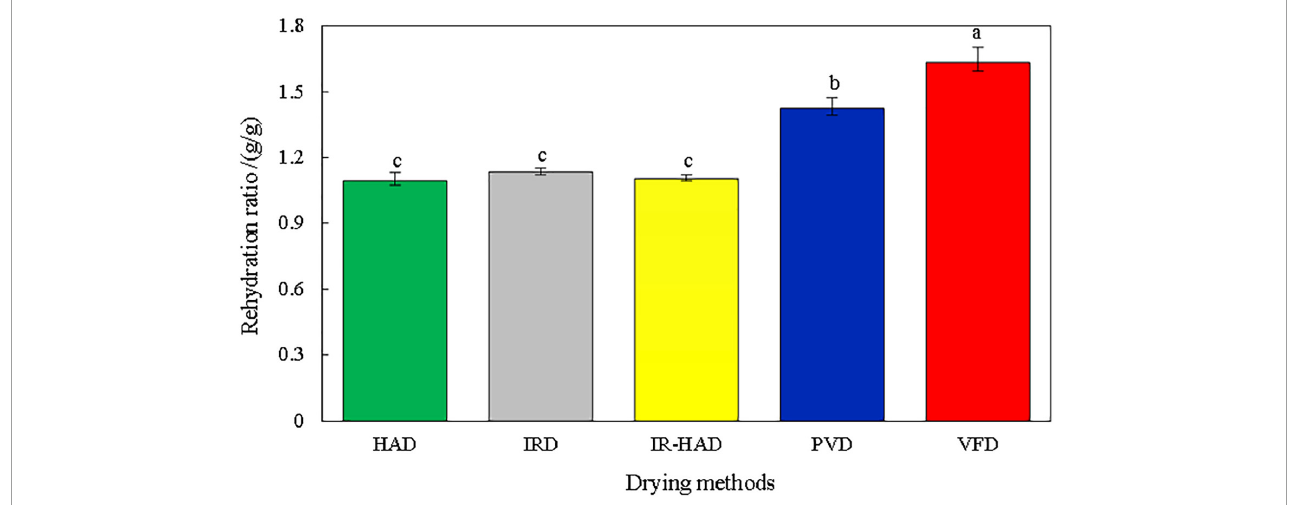
FIGURE4 Effect of different drying methods on rehydration ratio of sea buckthorn berries. Different letters in the figure reveal significant differences ( P < 0.05) according to the Duncan test.